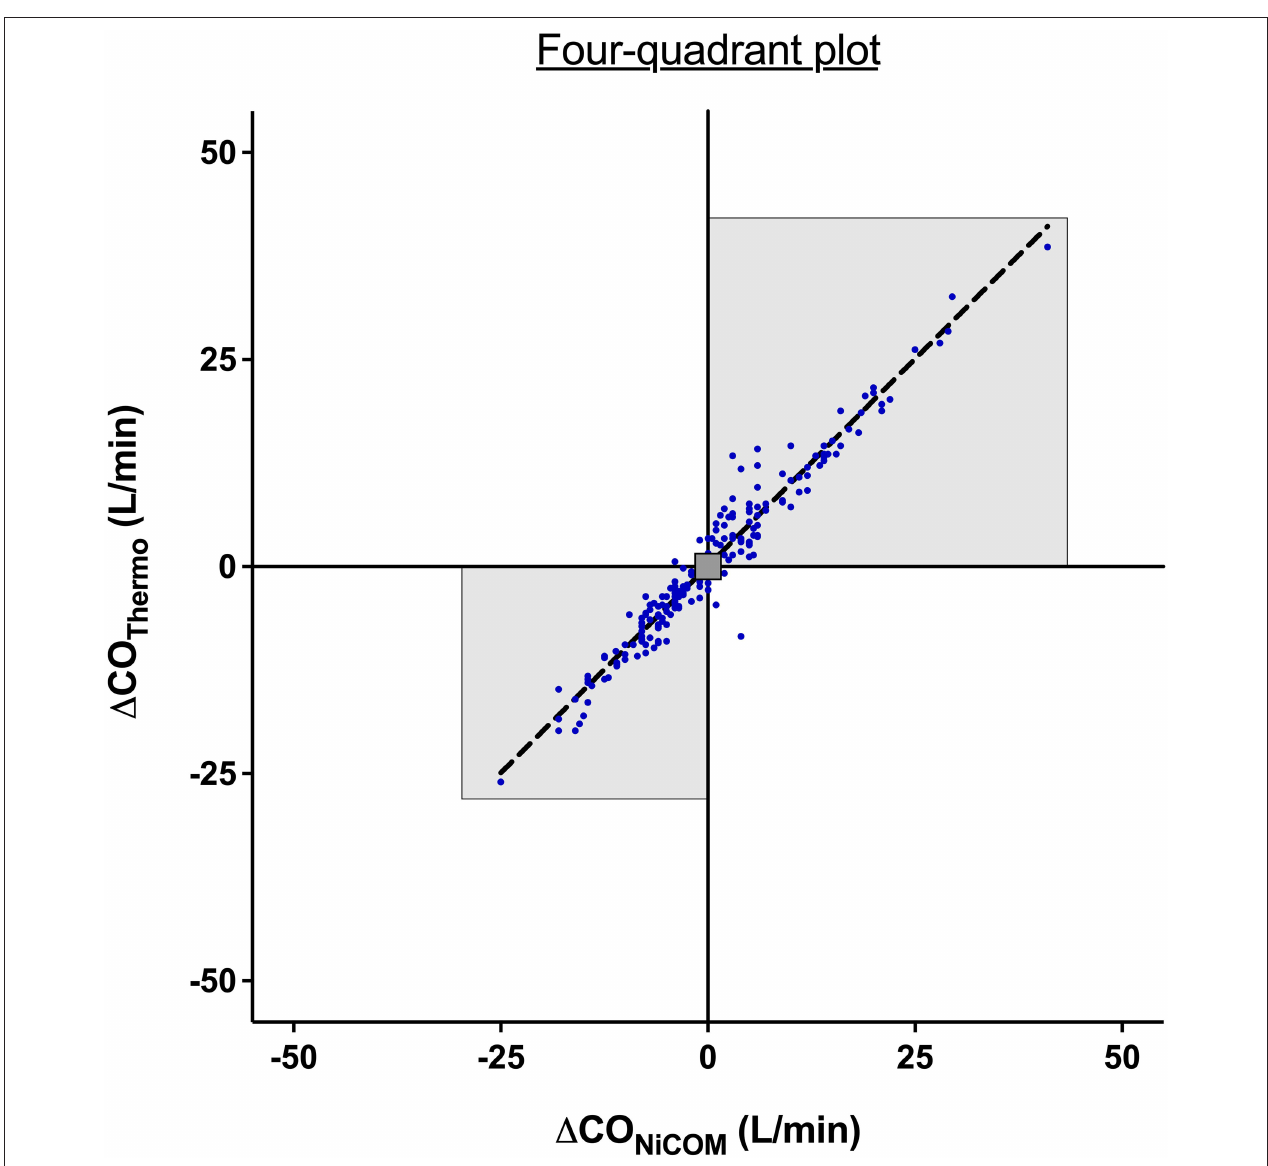
FIGURE 3 | Four-quadrant plot to assess the agreement in the direction of change between bioreactance and thermodilution. An exclusion zone of values < 1 L/min was applied. The highlighted area represents the two quadrants containing the delta cardiac output pairs with the same direction of change. The dotted line represents the line of identity where x =